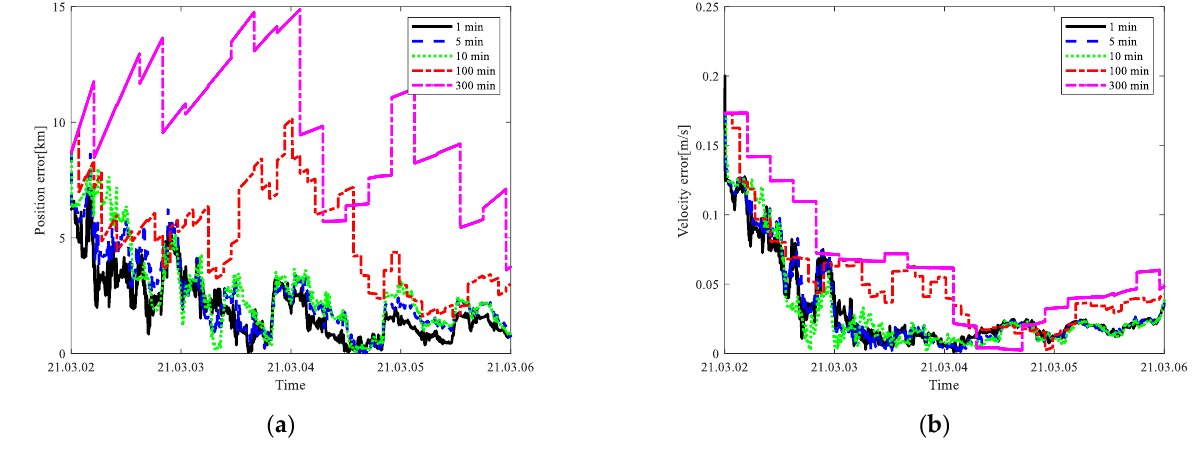
Figure 3. Navigation results of the celestial navigation using time delay measurement with different sampling periods. ( a ) Position error. ( b ) Velocity error. Table 3. Navigation results with different sampling periods.